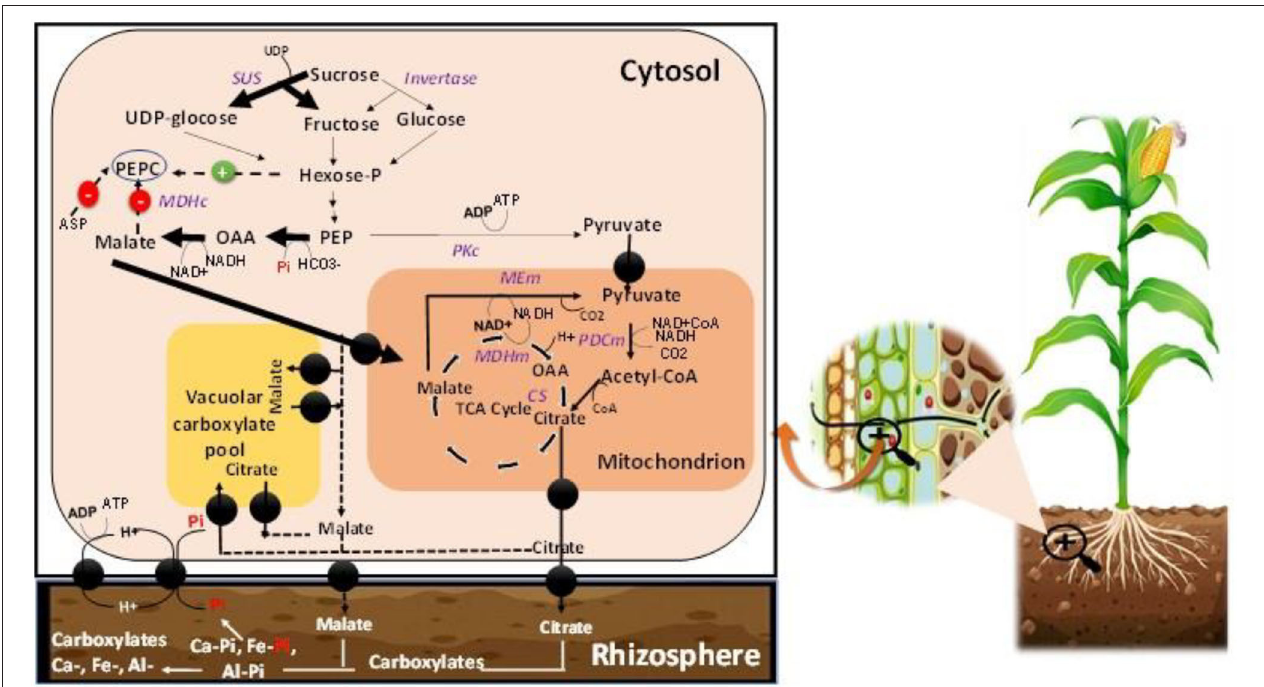
FIGURE 5 | Pi-dependent regulation of the plant growth process at the cellular levels. UDP-glucose, Uridine diphosphate glucose; PEPC, Phosphoenolpyruvate carboxylase; Hexose-P, Hexose phosphate; OAA, Oxaloacetate; ASP, aspartate; PEP, Phosphoenolpyruvate; SUS, Sucrose synthase; PKc, Cytosolic pyruvate kinase; MDHc, Cytosolic malate dehydrogenase; MDHm, Mitochondrial malate dehydrogenase; MEm, Mitochondrial malic enzyme; PDCm, mitochondrial pyruvate dehydrogenase complex; CS, Citrate synthase. The image illustration was redesigned by NB and